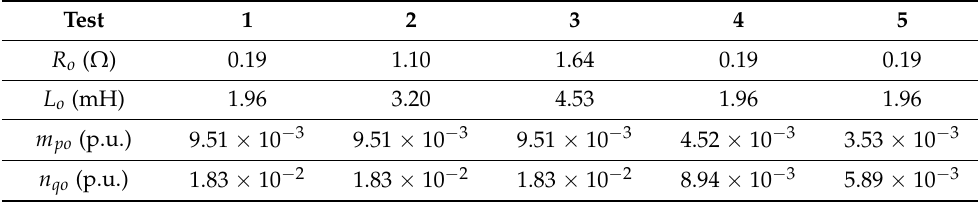
Table 4. Line impedance and droop sets for the six-bus system.